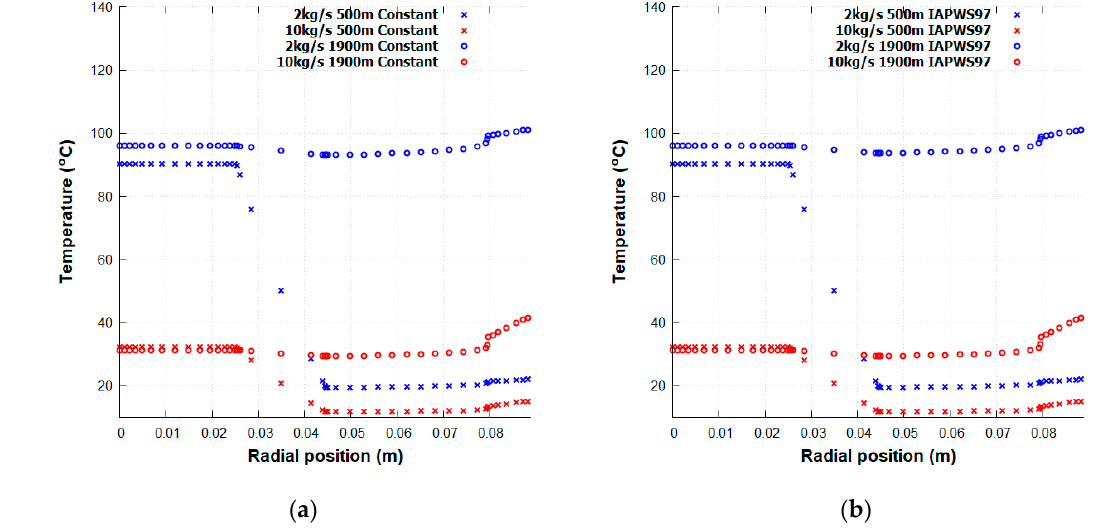
Figure 5. CFD study. ( a ) CFD-based radial Temperature distribution at − 500 m and − 1900 m with constant water properties. ( b ) CFD-based radial Temperature distribution at − 500 m and − 1900 m using the IAPWS IF97 properties. The blue values are set for the mass flow rate injection of 2 kg/s and the red values for 10 kg/s.